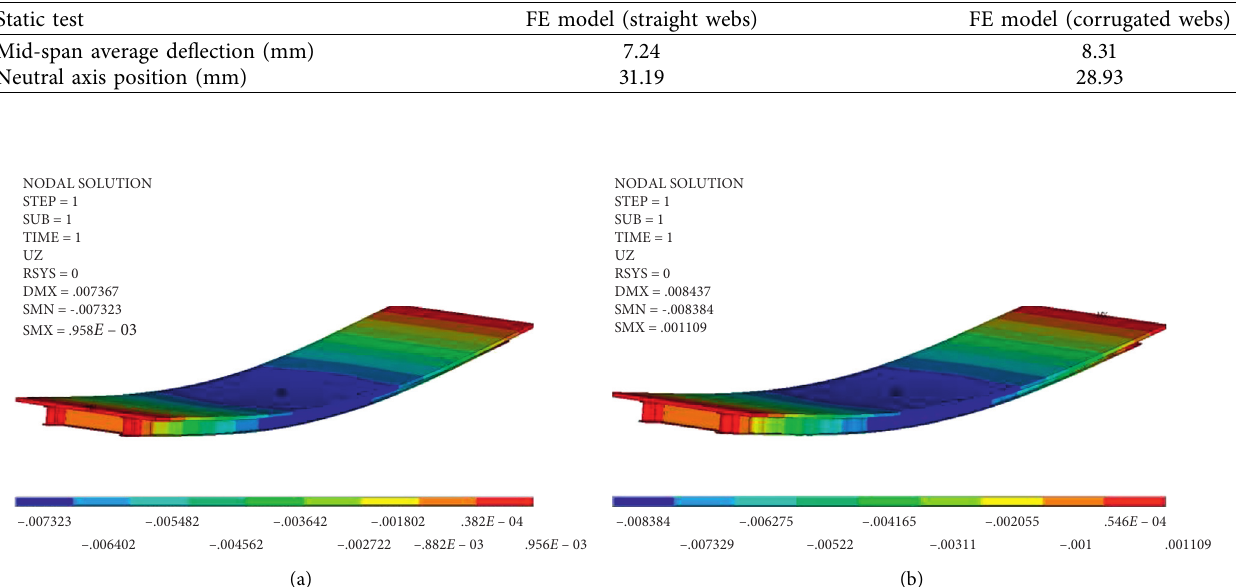
Table 6: Mid-span deflection and neutral axis position: FE model (straight webs) vs. FE model (corrugated webs).